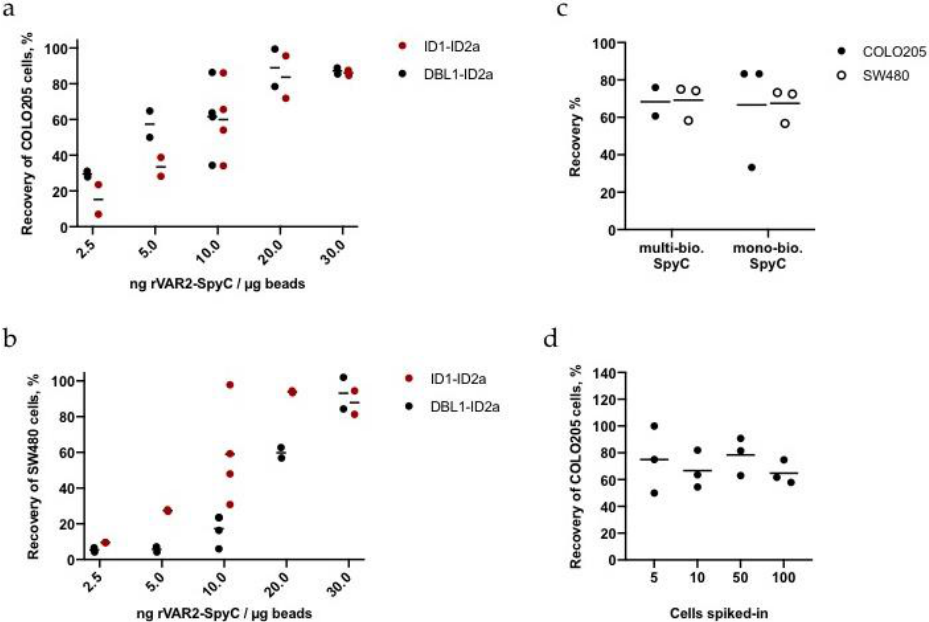
Figure 3. Optimization of the rVAR2 to bead ratio for capture of cancer cells in blood. ( a ) and ( b ) Recovery of COLO205 or SW480 cells from 1 mL blood after capture experiments with different protein to bead ratios. Each ratio was tested in duplicates or quadruplicates. Lines represent mean values. ( c ) Capture experiment of COLO205 and SW480 cells spiked into blood using DBL1-ID2a with either multi- or mono-biotinylated SpyCatcher linkage to magnetic beads. Lines represent mean values. ( d ) Sensitivity measurements of the direct capture method of approximately 5, 10, 50, or 100 COLO205 cells in 3 mL blood using DBL1-ID2a. Lines represent mean values. The exact cell numbers can be found in Table S1.